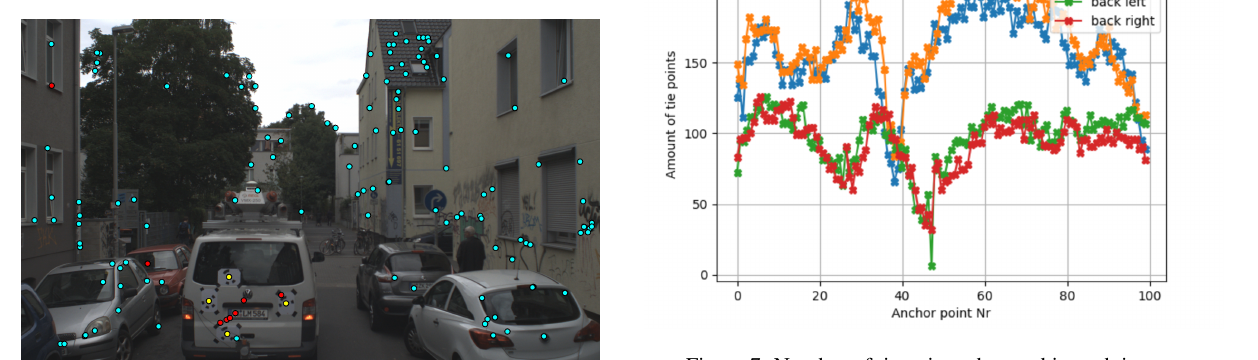
Figure 7. Number of tie points observed in each